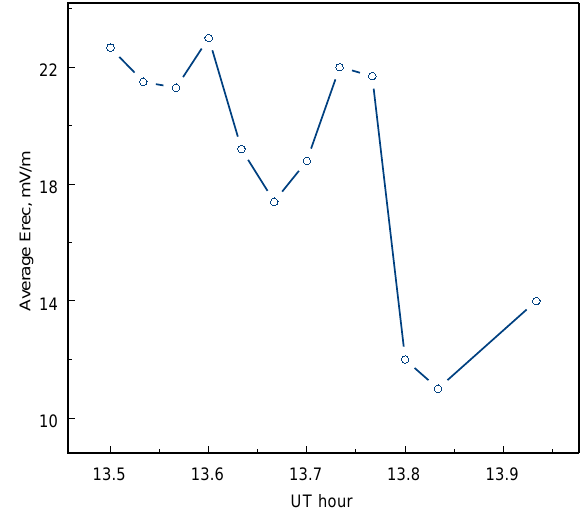
Fig. 8. The average reconnection electric field ( E rec ) in the mag- netic longitude sector (0–15 ◦ ) conjugate to the Equator-S satellite as a function of universal